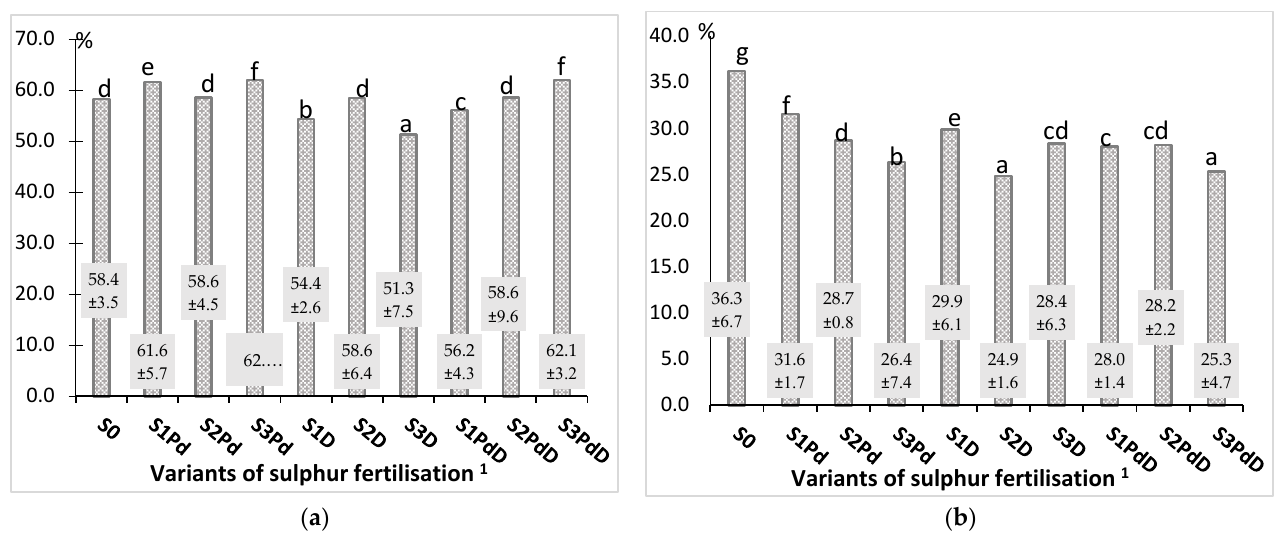
Figure 6. ( a ) Nitrogen harvest index on average for variants of sulphur fertilisation; ( b ) Sulphur harvest index on average for variants of sulphur fertilisation. 1 See Table 2; Means followed by the same letter are not statistically different at the α = 0.05 level . ±—standard d eviation.